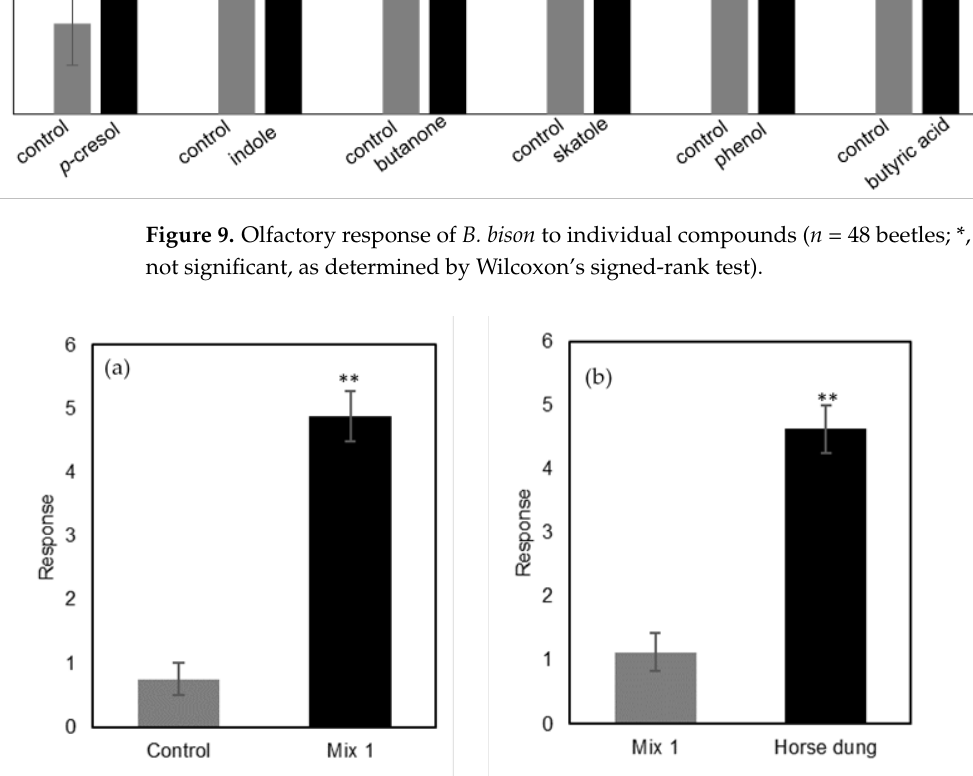
Figure 10. Olfactory responses of B. bison to ( a ) six-compound mixture ( p -cresol, indole, butanone, skatole, phenol, and butyric acid) vs. control, and ( b ) six-compound mixture vs. fresh horse dung ( n = 48 beetles; **, p < 0.01, as determined by Wilcoxon’s signed -rank test).